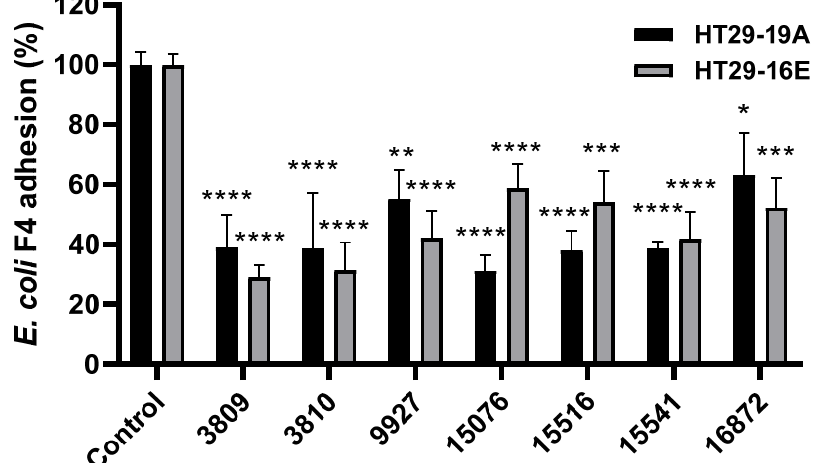
Figure 2. Adhesion of ETEC F4 to HT29-19A and HT29-16E cells after pre-treatment with seven Bacillus spp. strains. HT29-19A and HT29-16E cell monolayers were incubated with the seven Bacillus